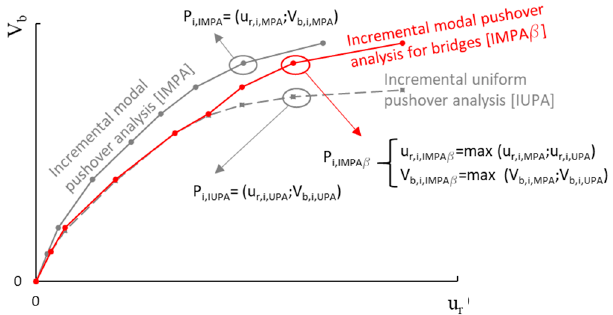
Figure 4. Evaluation of the IMPA β capacity curve: envelope of IUPA and IMPA.